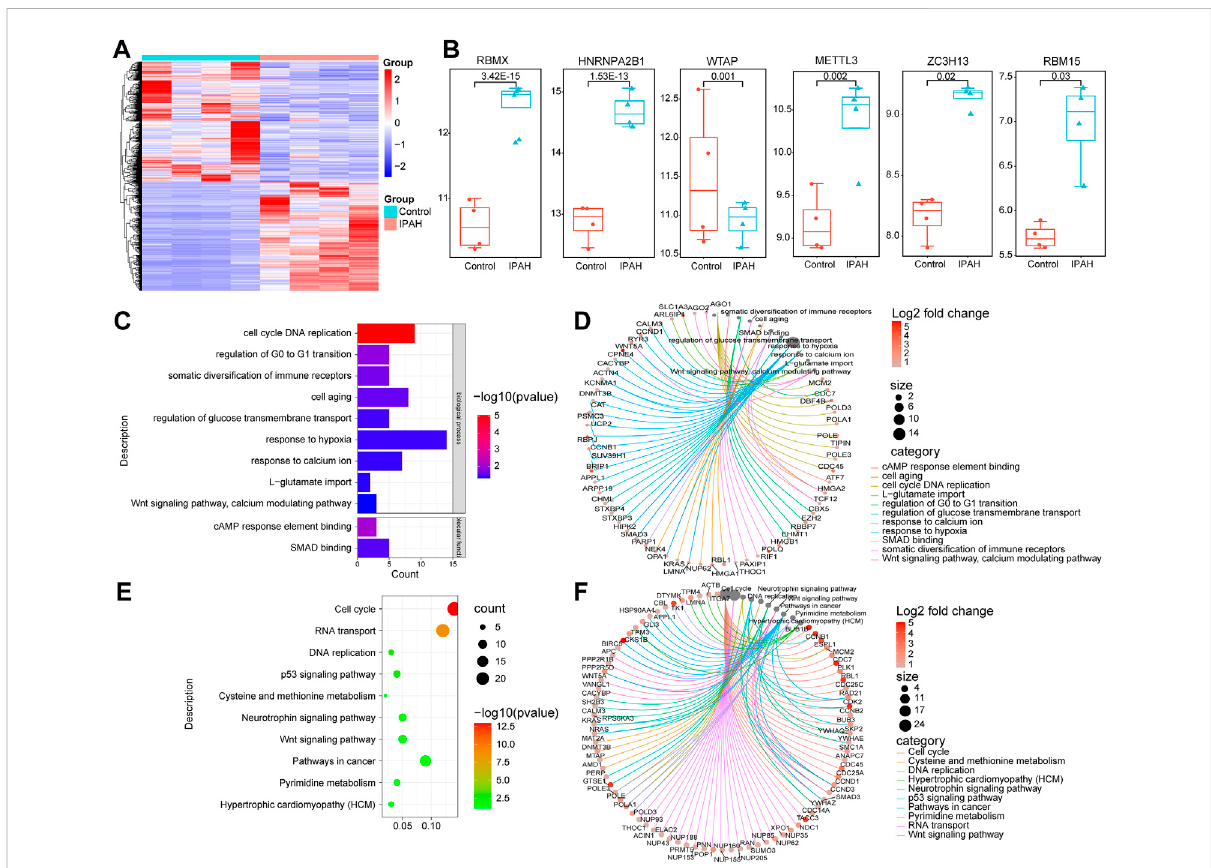
FIGURE 8 HNRNPA2B1 was signi fi cantly elevated in the pulmonary artery SMCs isolated from IPAH patients. (A) The heatmap of the differentially expressed genes in the datasets. (B) The differences in the expressions of m6A regulators. (C) The GO analysis of the target genes of m6A that overlapped with the upregulated DEGs. (D) The genes involved in these functions are presented. (E) The results of the KEGG analysis of the target genes of HNRNPA2B1 overlapped with the upregulated DEGs. (F) The genes involved in these functions are